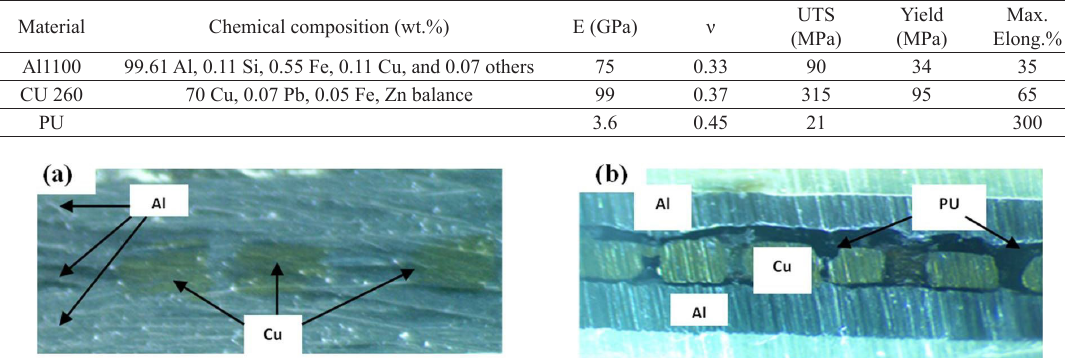
Figure 3. (a) Cross section of AL/perforated CU/AL, and (b) AL/PU/perforated CU/PU/AL sandwich composites.